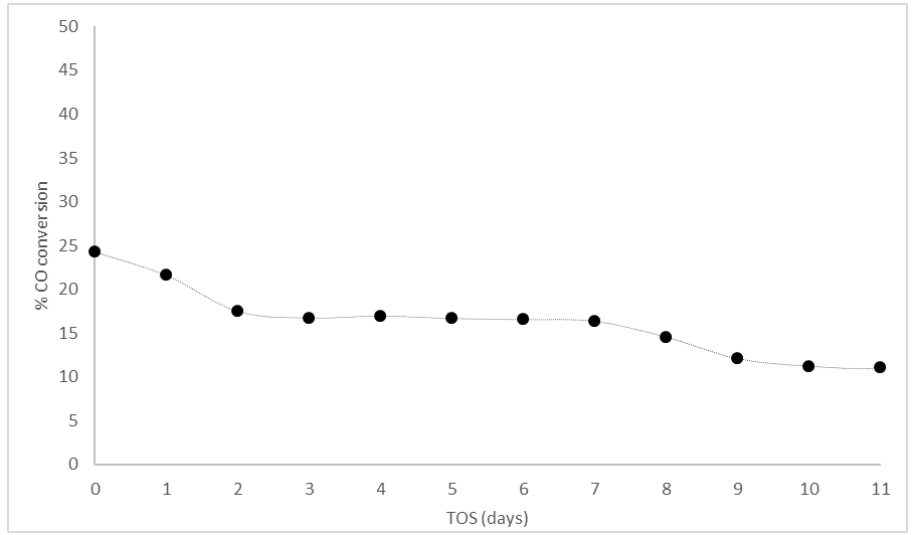
Figure 5. CO conversion for R4 (refer to Tables 3 and 4 for reaction details).